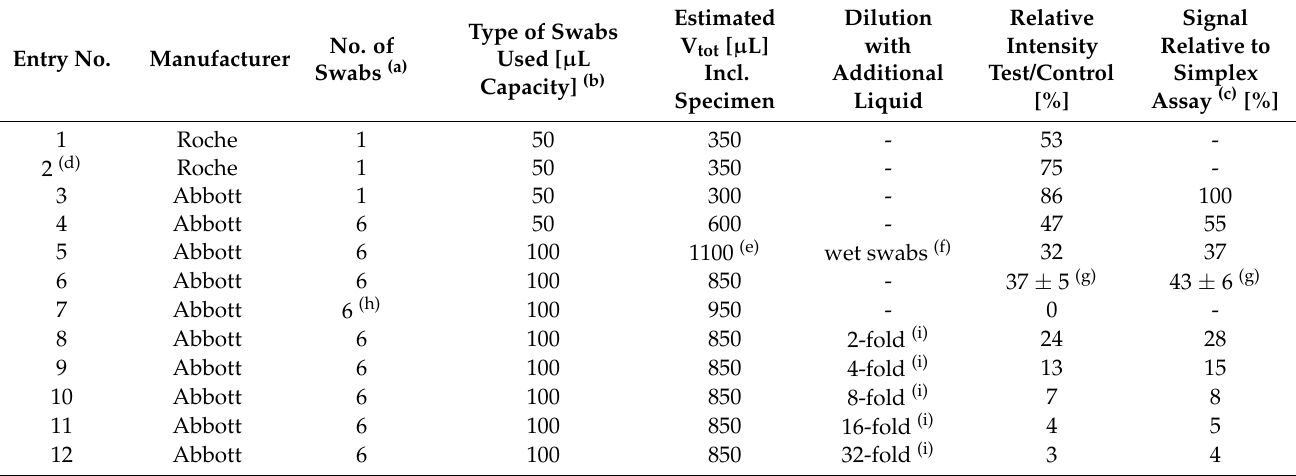
Table 1. Results of rapid antigen test with or without pooling of